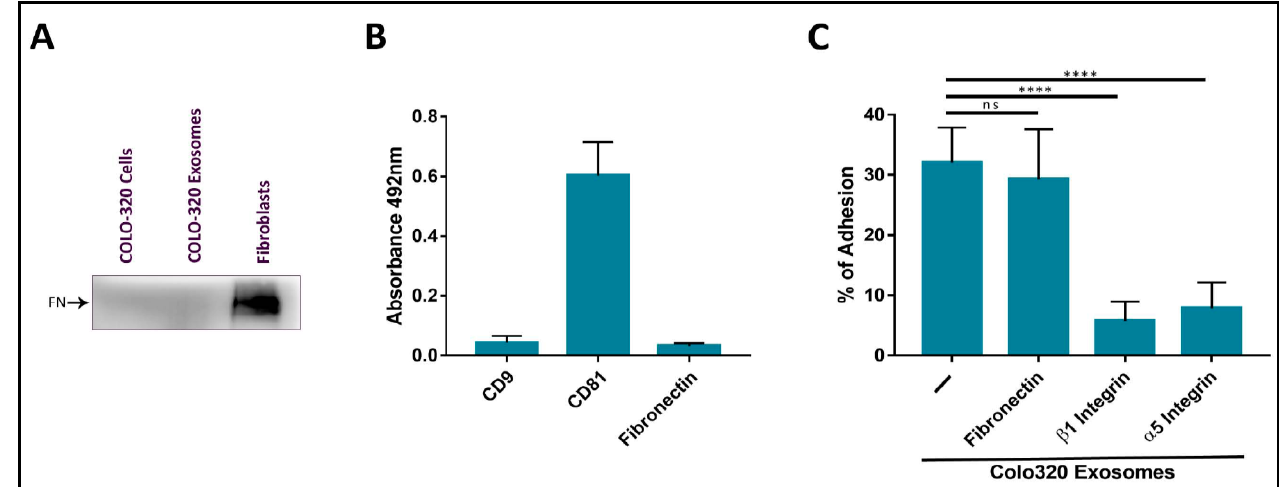
Figure 3. The adhesion of CRC Colo-320 cells to exosomes was specifically mediated by integrin α 5 β 1 but not by fibronectin. ( A ) Western Blot of Colo-320 cells and their exosomes shows lack of expression of fibronectin. As a positive control, abundant fibronectin was detected in a fibroblasts lysate. Blots are representative of three different experiments. ( B ) Detection by enzyme-linked immunosorbent assay (ELISA) of CD9, CD81 and fibronectin on immobilized exosomes produced by Colo-320 cells. ( C ) Cell adhesion of Colo-320 cells to immobilized exosomes produced by these same cells was blocked by mAbs specific for integrin β1 or integrin α5, but not for fibronectin. The percentage of cells that remained adhered is indicated as mean ± SEM of four experiments, performed in duplicates. Statistical analysis performed was one-way ANOVA. **** p < 0.0001, ns: not statistically significant.